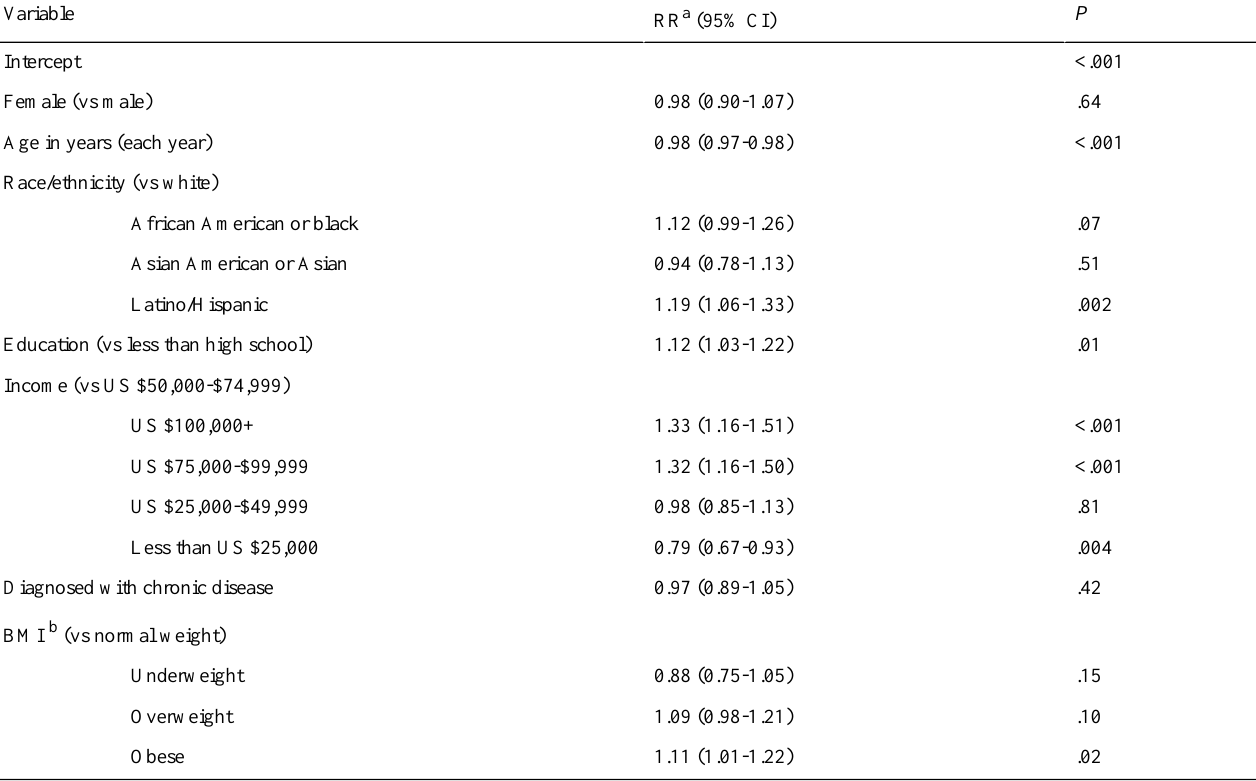
Table 3. Multivariable correlates of health app